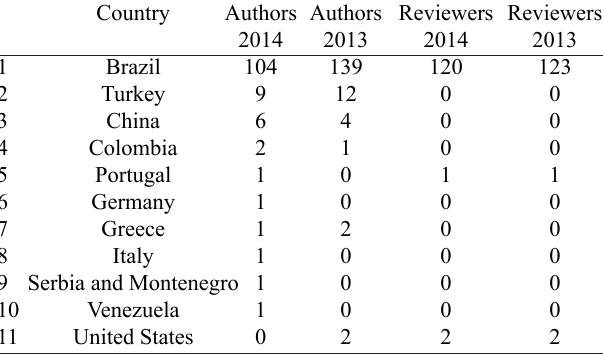
Table 2. Countries of origin of authors and reviewers of manuscripts submitted to Brazilian Journal of Cardiovascular Surgery in 2013 and